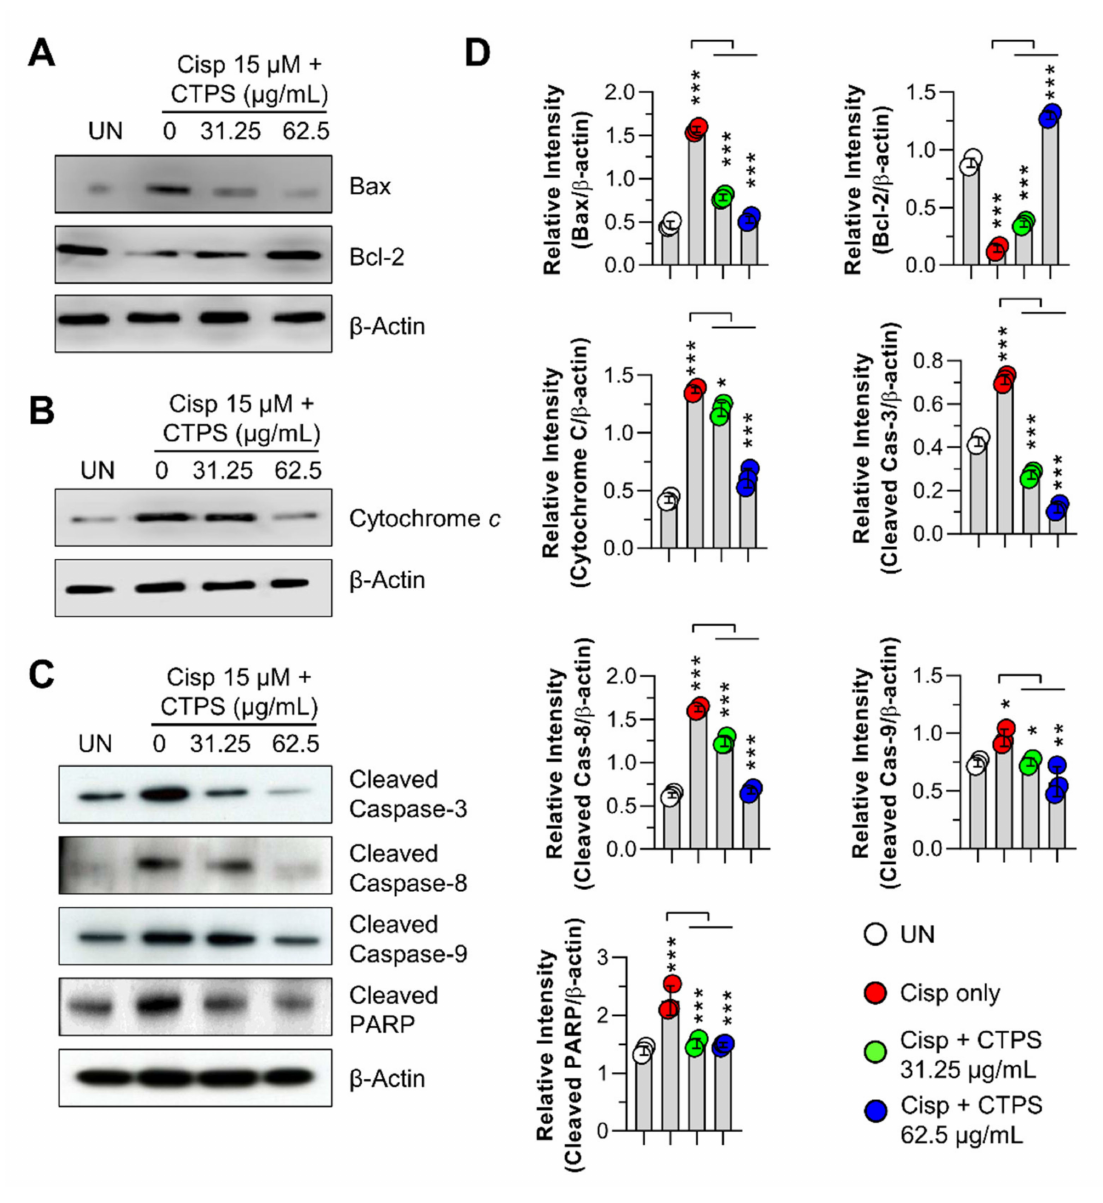
Figure 3. CTPS protects macrophages against cisplatin-induced cytotoxicity. Following pretreatment with CTPS (31.25 and 62.5 µ g/mL) for 2 h, non- or CTPS-treated RAW264.7 cells were stimulated with 15 µ M cisplatin for 24 h and then lysed. Proteins in the cell lysate were evaluated via western blotting. ( A ) Protein expression of Bax and Bcl-2 in cytosolic fractions. ( B ) Protein expression of cytochrome c in the cell lysate. ( C ) Protein expression of cleaved caspase-3, 8, 9, and PARP in cell lysate. β -actin was used as the loading control for cytosolic fractions. ( D ) Western blotting data are representative of three independent experiments. The data were analyzed using ImageJ program to compare the relative band intensity of each protein. The data are shown as the mean ± standard deviation ( n = 3). * p < 0.05, ** p < 0.01, or *** p < 0.001. UN, untreated cells; CTPS, Cudrania tricuspidata -derived polysaccharides; cisp,